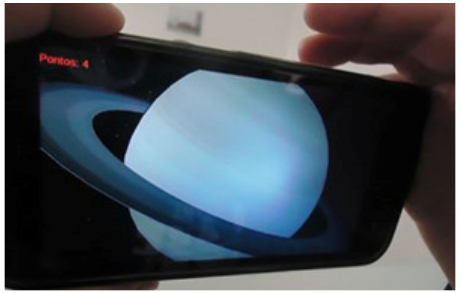
Figure 1. Saturn. This player has four points.